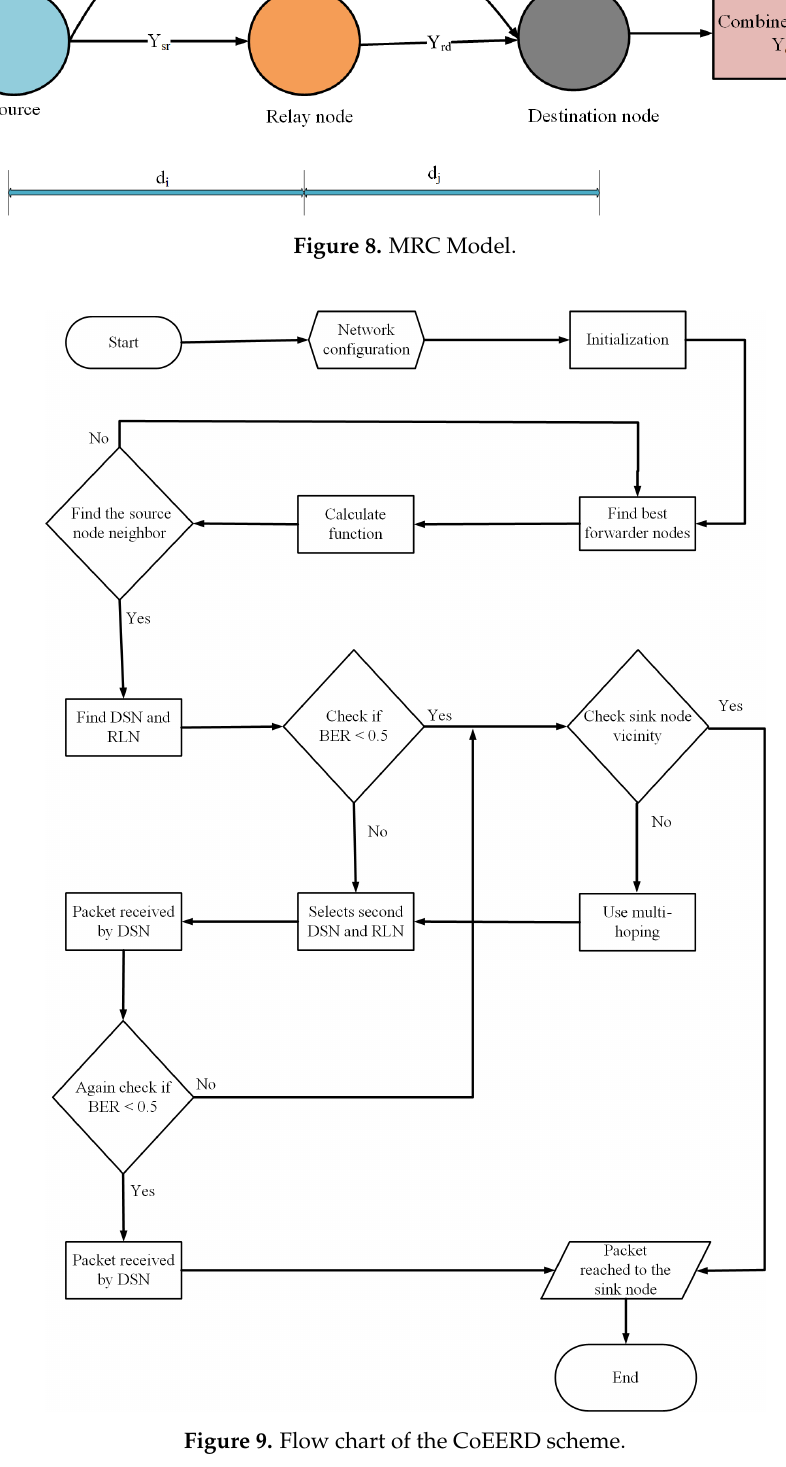
Figure 9. Flow chart of the CoEERD